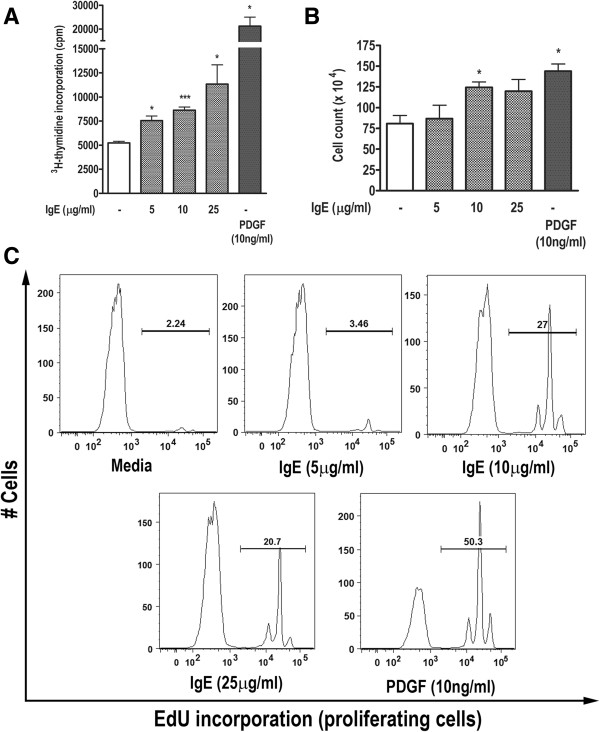
IgE induces DNA synthesis and cell proliferation in HASM cells. (A) Serum-starved HASM cells were stimulated with IgE (5–25 μg/ml), PDGF-BB (10 ng/ml), or left unstimulated. 3H-thymidine incorporation was measured by liquid scintillation counting and presented as cpm. (B) IgE or PDGF-BB-stimulated cells were trypsinized after 48 h and counted by hemocytometer. (C) HASM cells stimulated similar to (A) were subjected to EdU-incorporation assay. EdU positive cell populations from a representative experiment are shown. n = 3; *p < 0.05, ***p < 0.001 compared to unstimulated control.